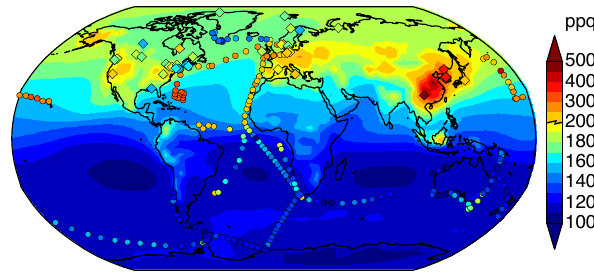
Fig. 5. Global distribution of total gaseous mercury (TGM) con- centrations in surface air (1ppq=10 − 15 molmol − 1 =8.97pgm − 3 at 273K, 1013hPa). Model values (background) are annual means for 2006–2008. Data for land sites (diamonds) are annual means for available years during 2000–2008 and all other observations from ship cruises (circles) are averaged over 1 ◦ latitude bins. Obser- vations include those used by Selin et al. (2007), plus additional sites in Europe ( Steffen et al., 2005, EMEP 2009), North Amer- ica (Steffen et al., 2005; Yatavelli et al., 2006; Stamenkovic et al., 2007; Temme et al., 2007; Choi et al., 2008; Sigler et al., 2009, E. Edgerton, personal communication, 2008), East Asia (Nguyen et al., 2007; Sakata and Asakura, 2007; Feng et al., 2008; Wan et al., 2009), South Africa (Slemr et al., 2010) and the Galathea cruise (Soerensen et al., 2010a). Note the change in linear color scale at 200ppq.